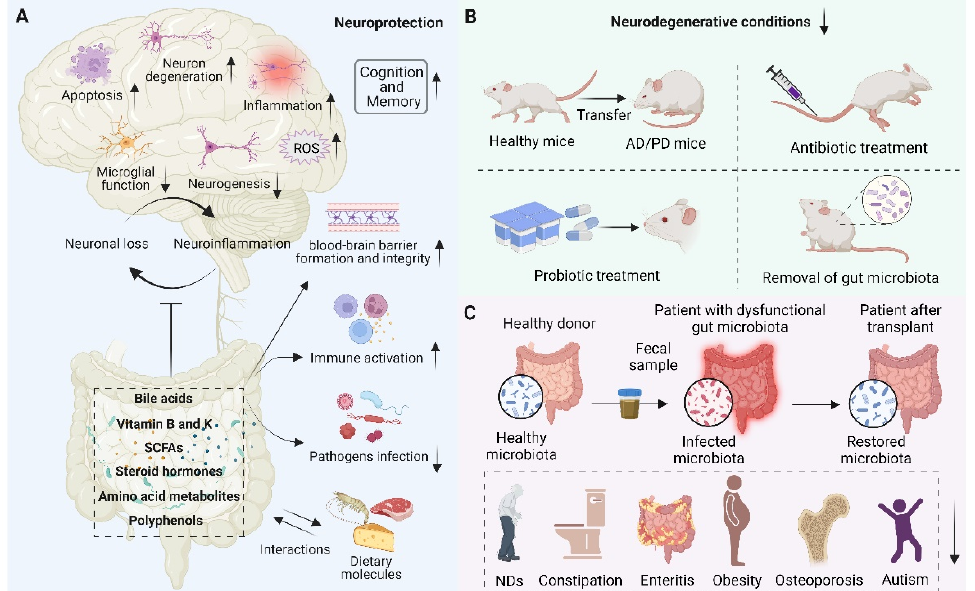
Figure 4. Schematic representation of the role of the gut microbiota in neuroprotection. ( A ) Beneficial metabolites such as bile acids, vitamins, short-chain fatty acids (SCFAs), steroid hormones, amino acid metabolites, polyphenols, etc., released by the gut microbiota and interacting with dietary molecules, can promote blood–brain barrier formation and integrity, reduce inflammation, reduce oxidative stress, reduce neuronal apoptosis, activate immune response, prevent pathogen infection, and thus play an important role in neuroprotection. ( B ) Fecal microbial transfer (FMT), antibiotic and probiotic treatment, and removal of gut microbiota were found to decrease neurodegenerative conditions and reduce the pathophysiology of NDs. ( C ) The scheme of transferring the gut microbiota from a